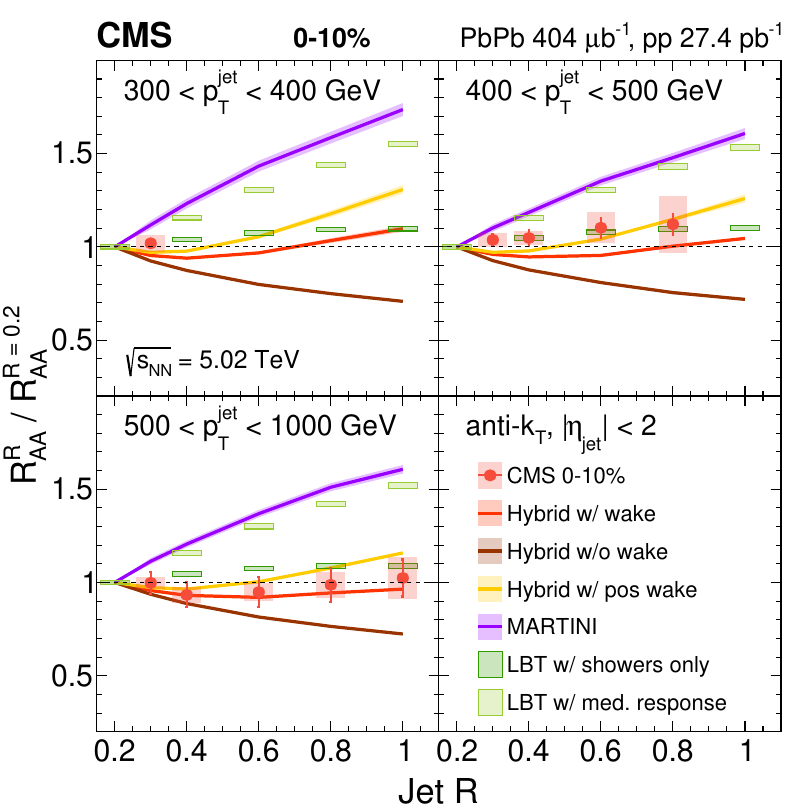
for jets with | η jet | < 2 . 0 , as a function of R , for R = 0 . 3 – Figure 12 . The double ratio R R /R R =0 . 2 AA AA 1 . 0 with respect to R = 0 . 2 , in various p jet ranges for the 0–10% centrality class. The statistical T uncertainties of data are shown as the vertical lines, whereas the systematic uncertainties are shown as the shaded boxes. The width of the boxes carries no meaning. The predictions from the Hybrid (dark orange, brown and yellow), Martini (purple), and lbt (lime and dark green) models are compared to the data as colored